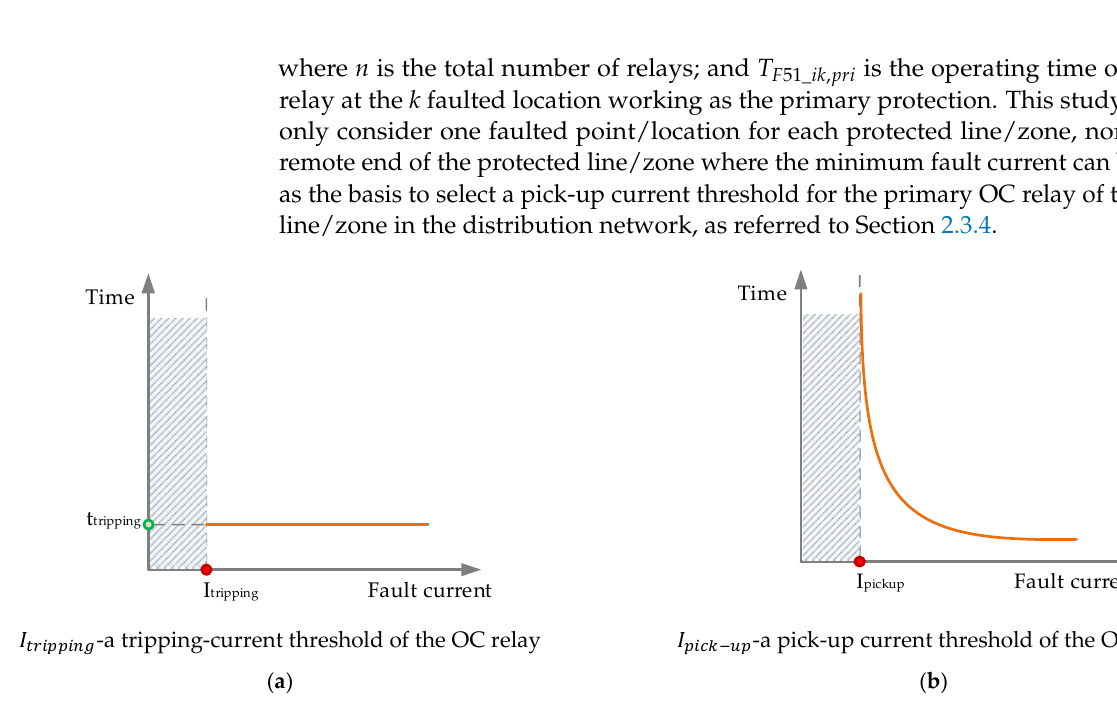
Figure 1. Illustration of protection characteristic curves ( a ) 50P/G–definite-time overcurrent function and ( b ) 51P/G–inverse-time overcurrent function.